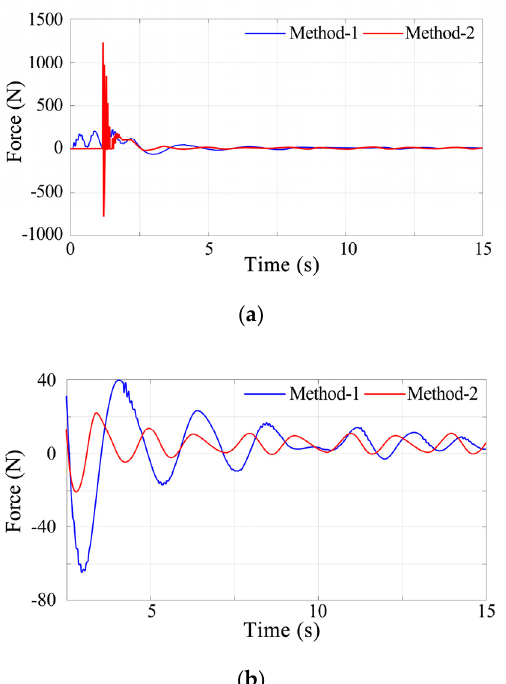
Figure 11. Horizontal tension force to the hinged joint between cable and float: ( a ) comparison of Method 1 and Method 2; ( b ) enlarged force response curves.